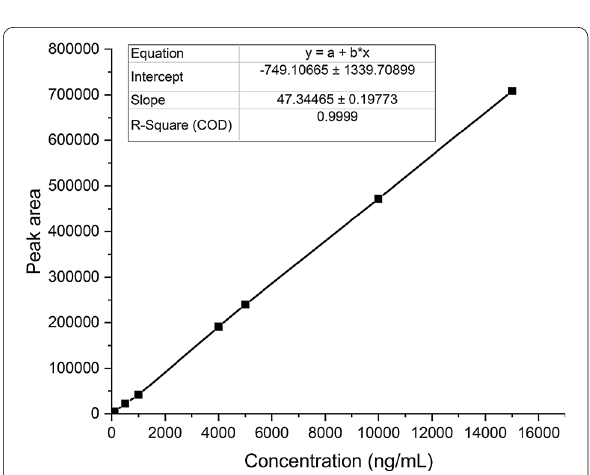
Fig. 2 Calibration curve of